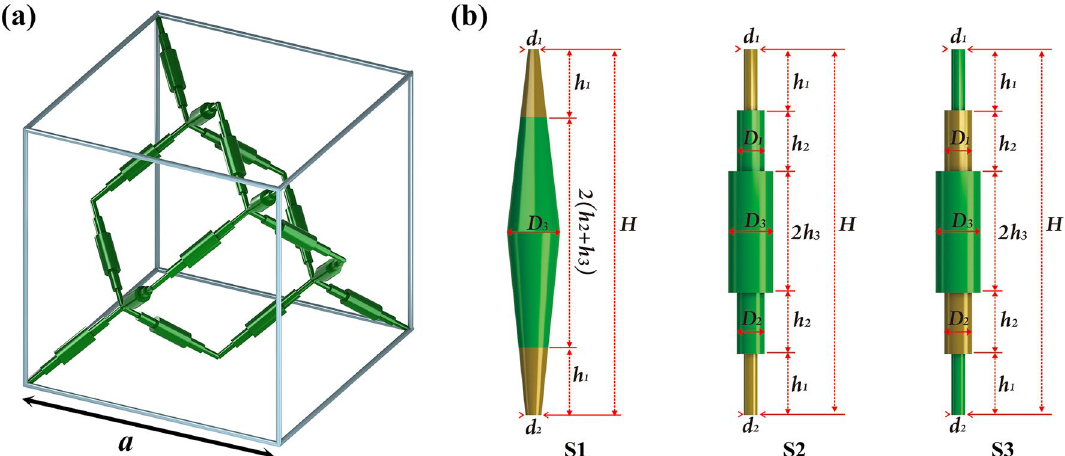
Figure 1. ( a ) The unit cell structure diagram of the multilayer composite cylindrical three-dimensional PMs. ( b ) Primitive structure diagrams of three locally resonance